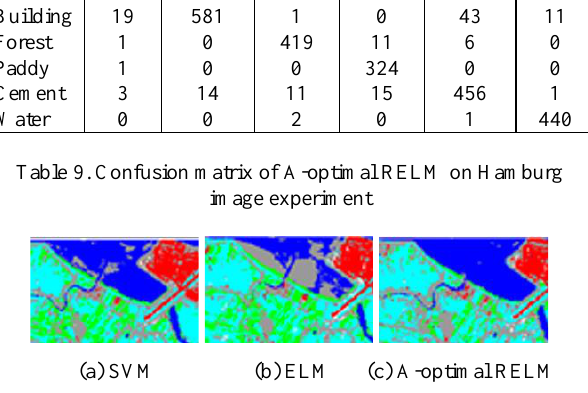
Figure 5. Part of misclassification details of watershed and cement land in Hamburg